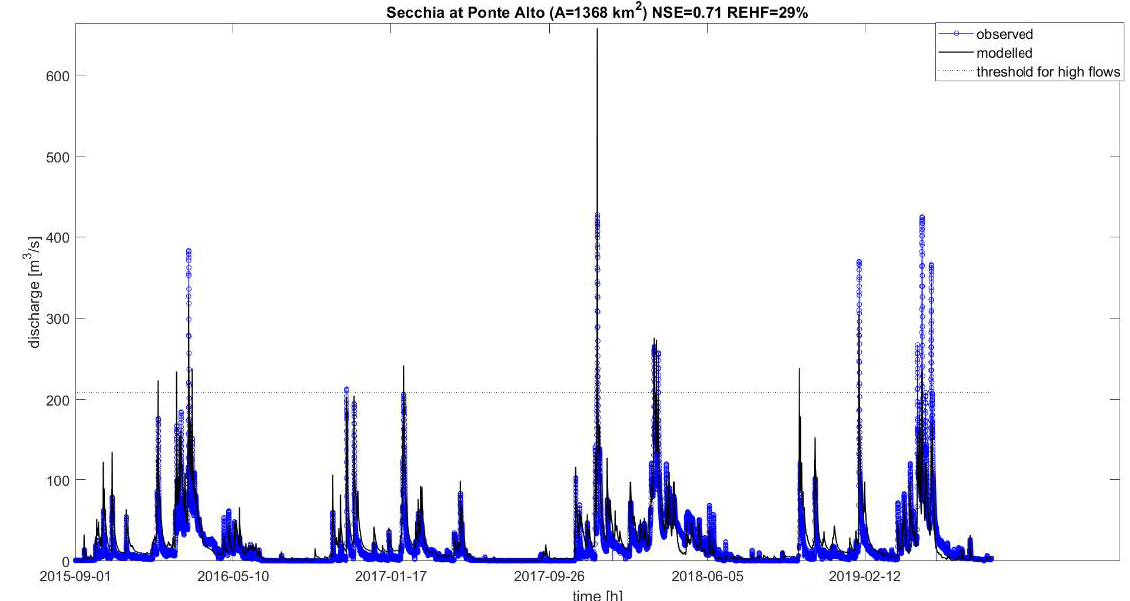
Figure 17. Comparison between observed and modelled hydrographs for a section not calibrated but with reliable observed streamflow data.